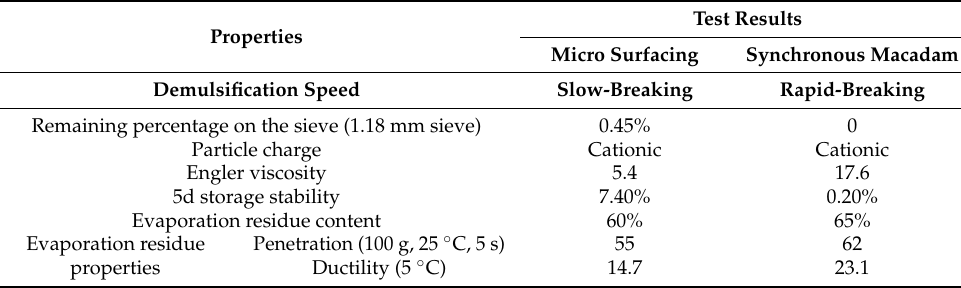
Table 1. Properties of emulsified asphalt in the upper layer and transition